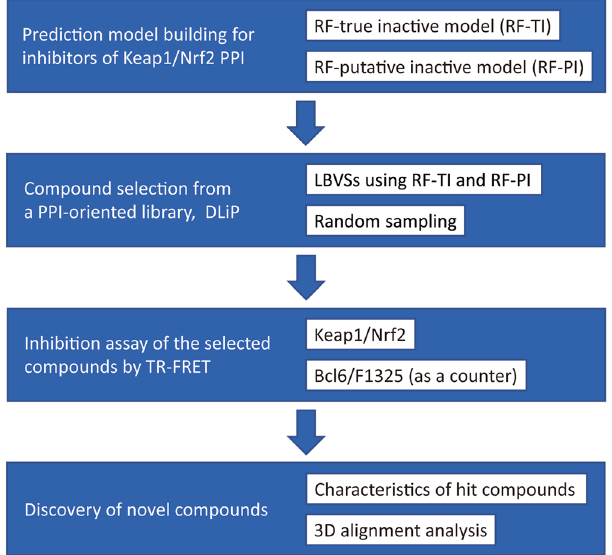
Figure 1. Overview of the process to discover new Keap1/Nrf2 inhibitors.